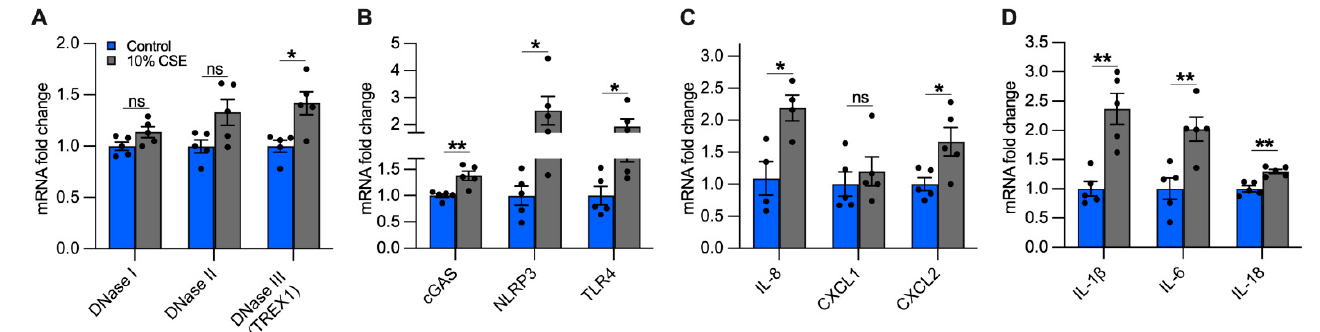
Figure 6. A sublethal dose of CSE upregulates the expression of DNase III, DNA-sensing receptors, and cytokines involved in neutrophil and macrophage recruitment. Bar graphs reporting the gene expression in cells exposed for 24 h to a sublethal dose of (10%) CSE as compared with the control: ( A ) DNases I-III, ( B ) cGAS, NLRP3, TLR4, ( C ) IL-8, CXCL1, CXCL2, and ( D ) IL-1 β , IL-6, IL-18. Data are shown as mean ± SEM of independent experiments ( n ≥ 4), indicated as circles. CSE, cigarette smoke extract; control, CSE-unexposed cells. ns, no statistical significance; * p < 0.05, ** p < 0.01 were determined by an unpaired t ‐ test analysis with Welch’s correction.